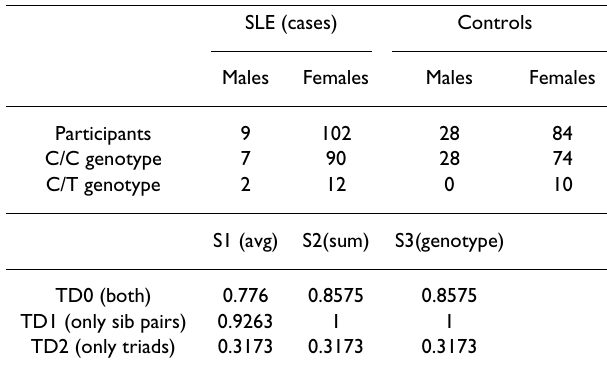
Table 1: Catalase SNP (rs 1000179) in cases with SLE and normal controls and pedigree disequilibrium